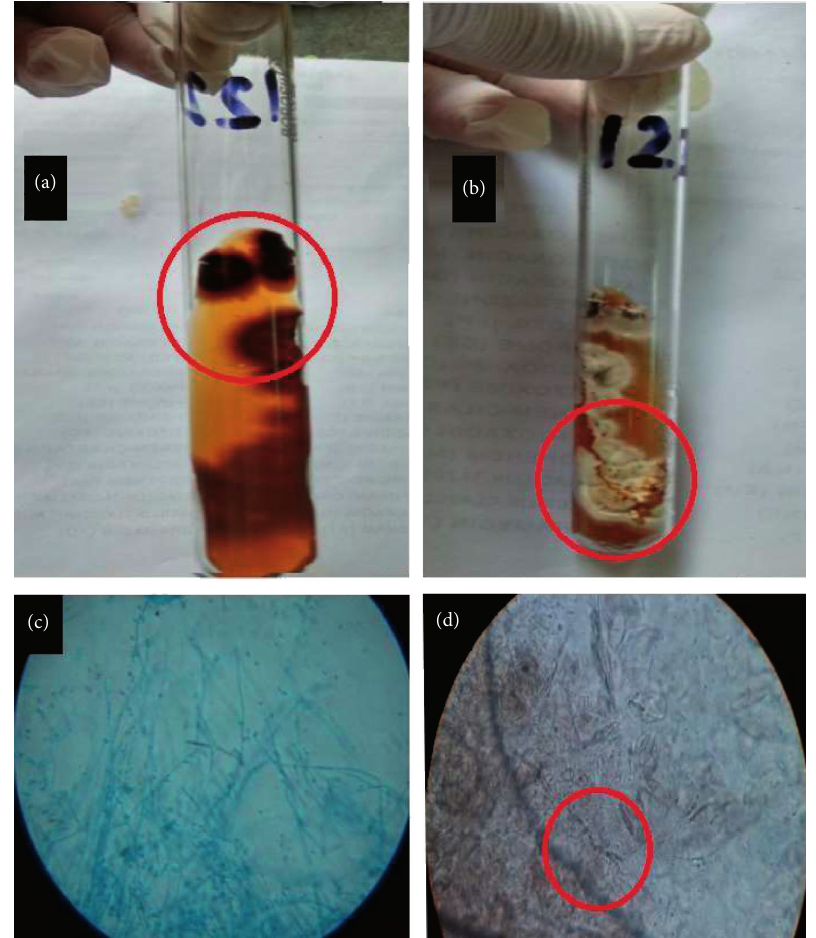
Figure 2: (a) Reverse side of fungal growth ( T. rubrum ) in SDA media. (b) Obverse side of fungal growth. (c) Lactophenol cotton blue (LCB) wet mount examination of fungal growth under high power microscopy (40X). (d) KOH mount examination of skin scarping under high power microscopy